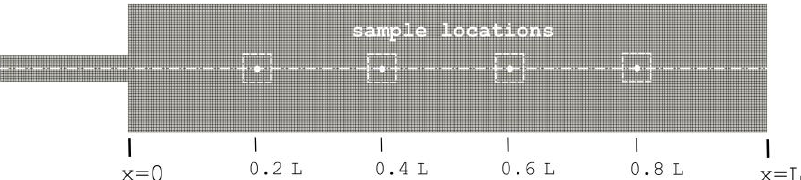
Figure A1. Location of sample points for error estimation (solution verification). L is the length of expanded channel in x direction.